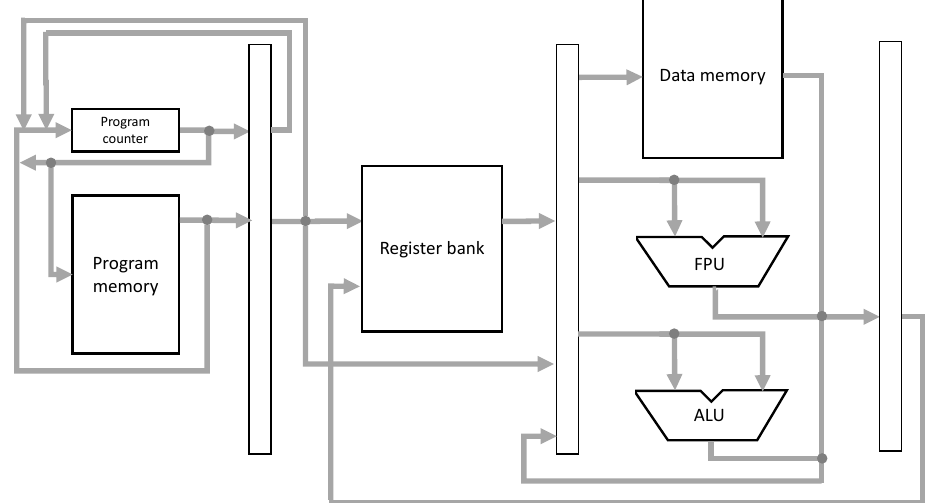
Figure 13. Simplified view of the pipeline architecture of